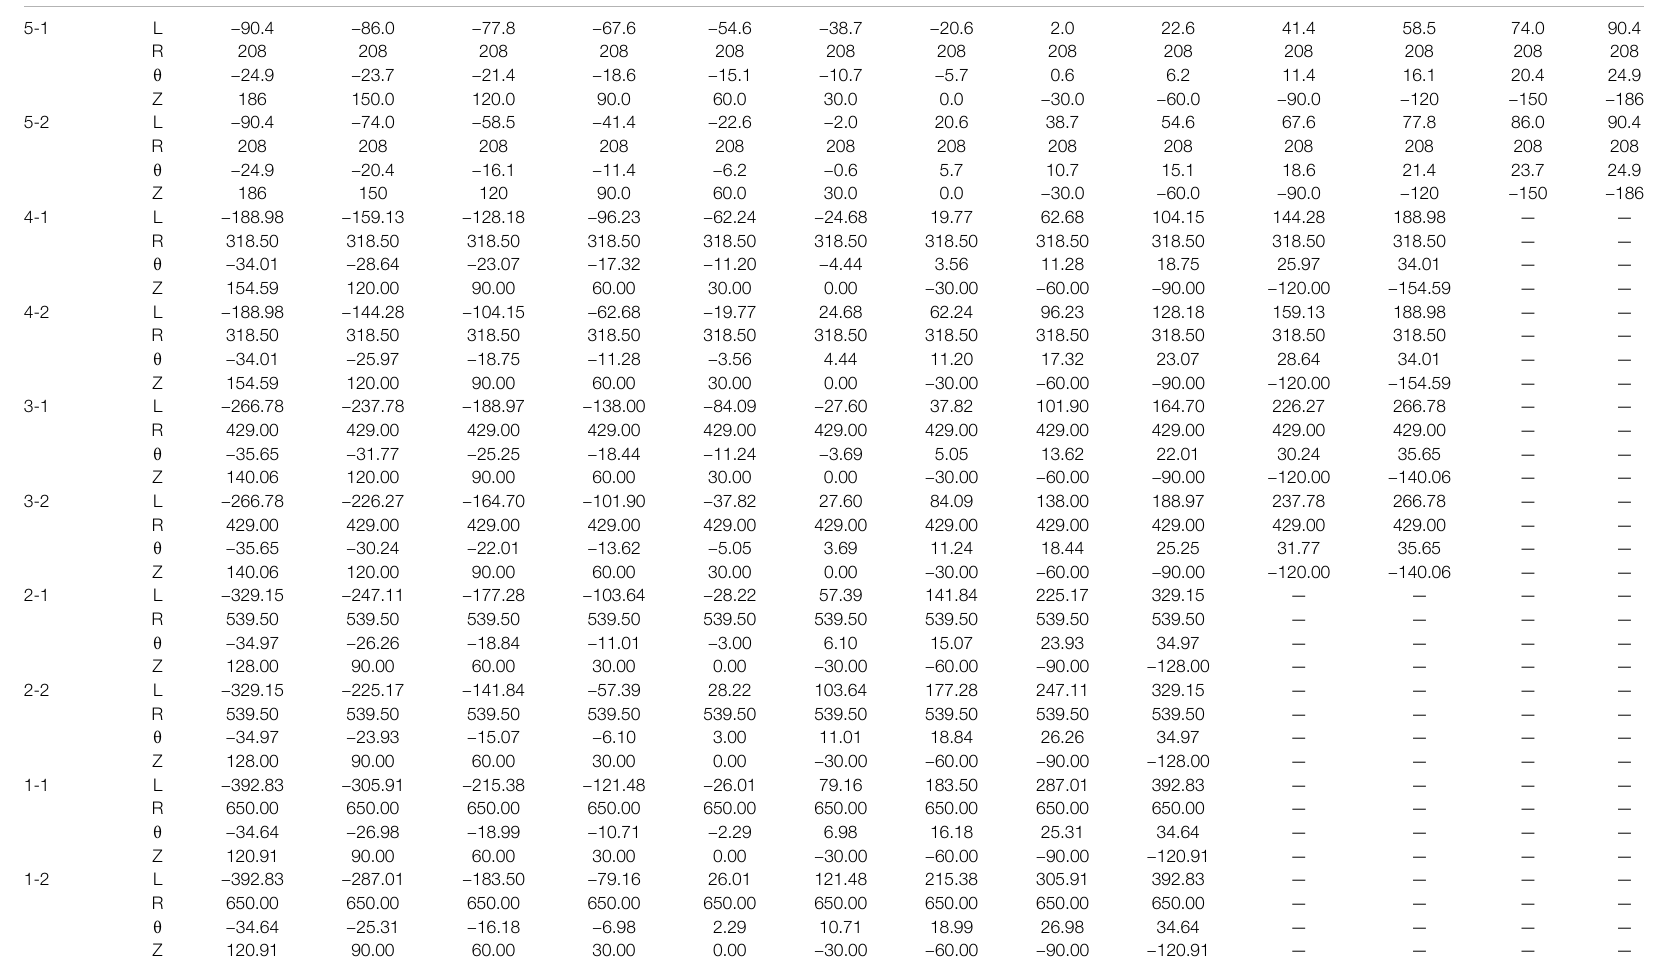
TABLE 4 | “ S ” -airfoil section data